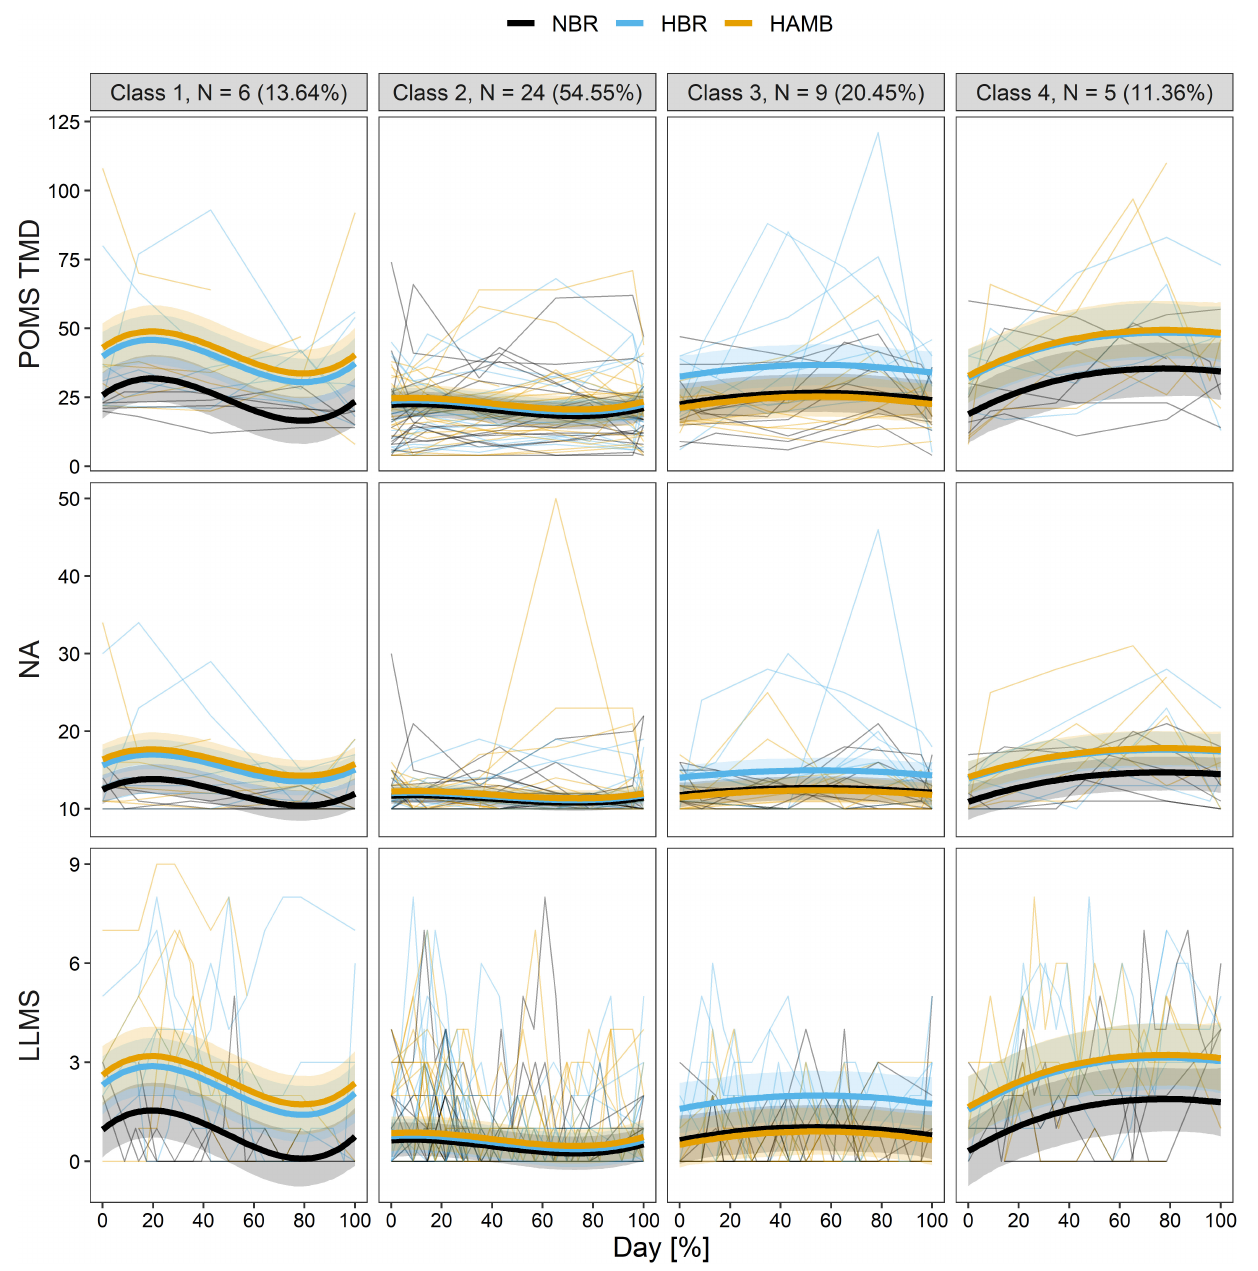
Frontiers in Physiology |